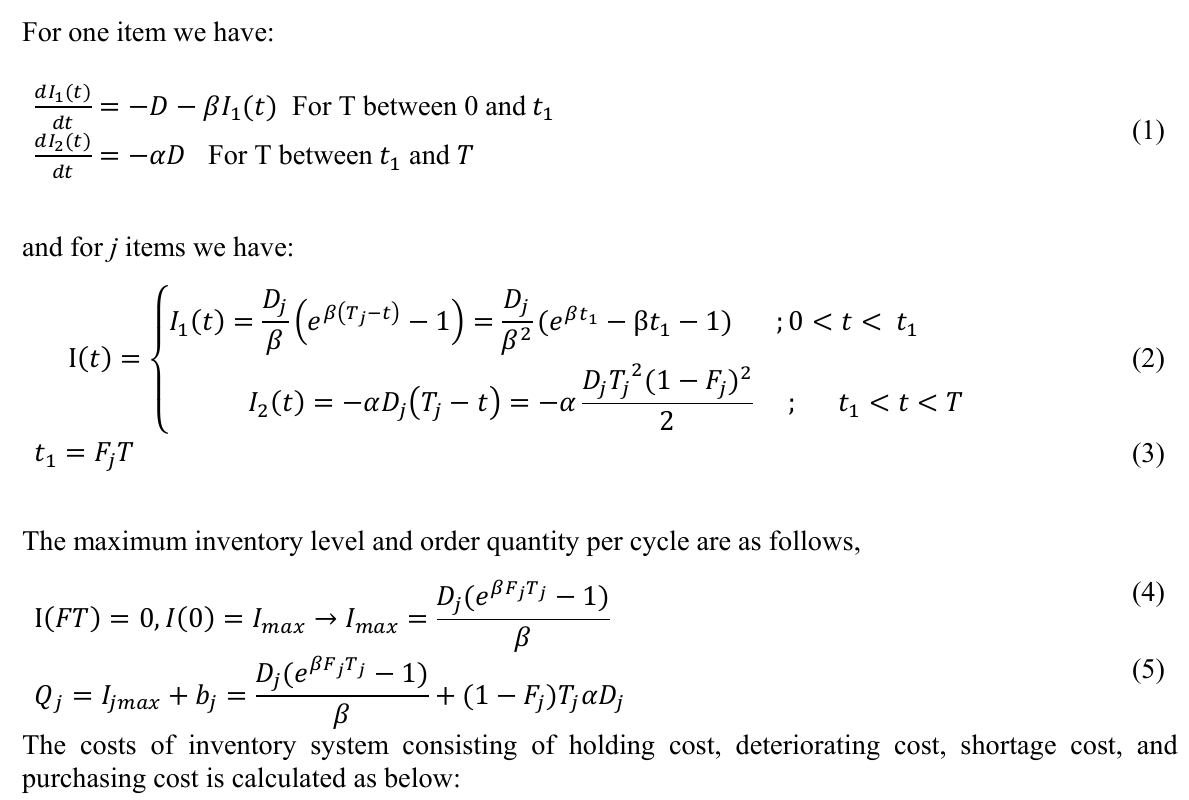
Fig. 1 . The EOQ model for constant deteriorating items with